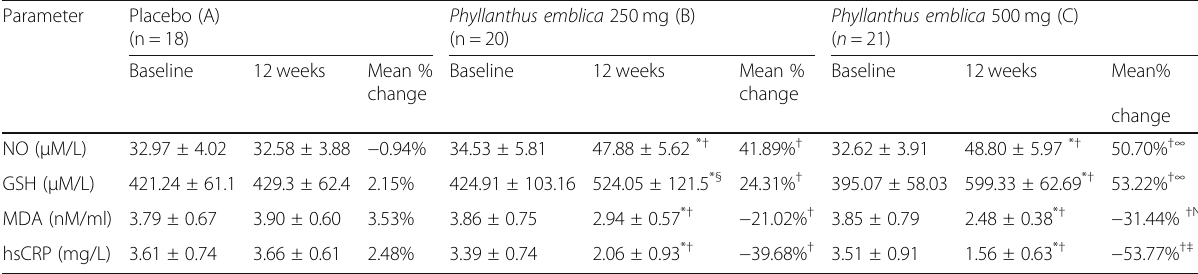
Table 3 Effect of Placebo, Phyllanthus emblica 250 mg and Phyllanthus emblica 500 mg on biomarkers Parameter